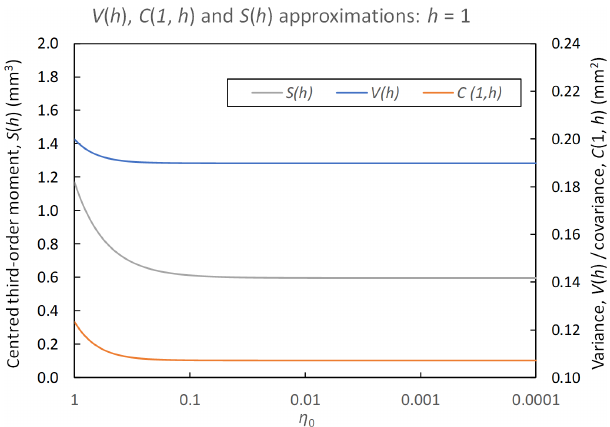
Figure 2. Changes of variance ( V (h) ), lag-1 autocovariance ( C( 1 ,h) ) and the third-order centred-moment ( S(h) ) approxima- tions at a 1h timescale ( h = 1) for η 0 ∈ ( 0 . 0001 , 1 ) . Parameters used are λ = 0 . 025, µ x = 1 . 3, α = 2 . 5, ν = 0 . 28, κ = 0 . 65 and φ = 0 .